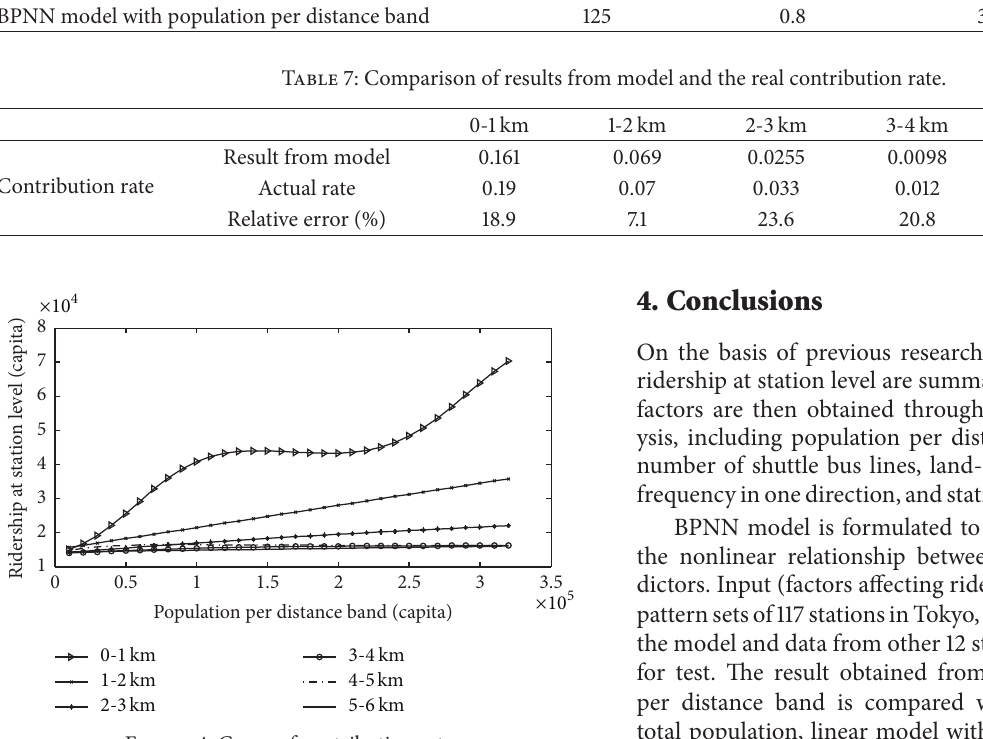
Figure 4: Curve of contribution